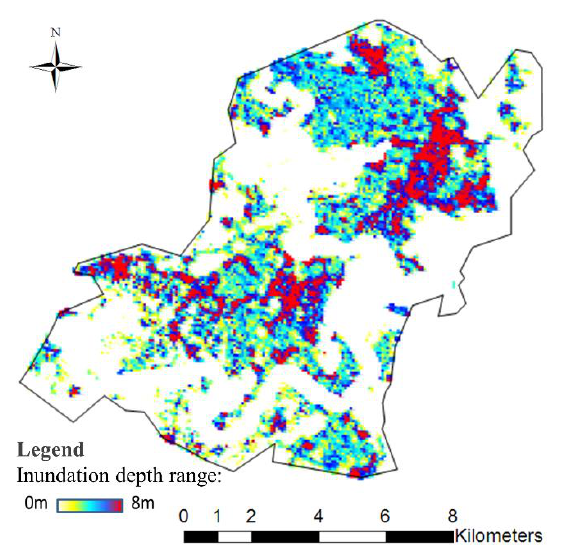
Figure 3. Maximum simulated flood map derived from the 2D flood model (a rainfall of 1653 mm in December 2014).